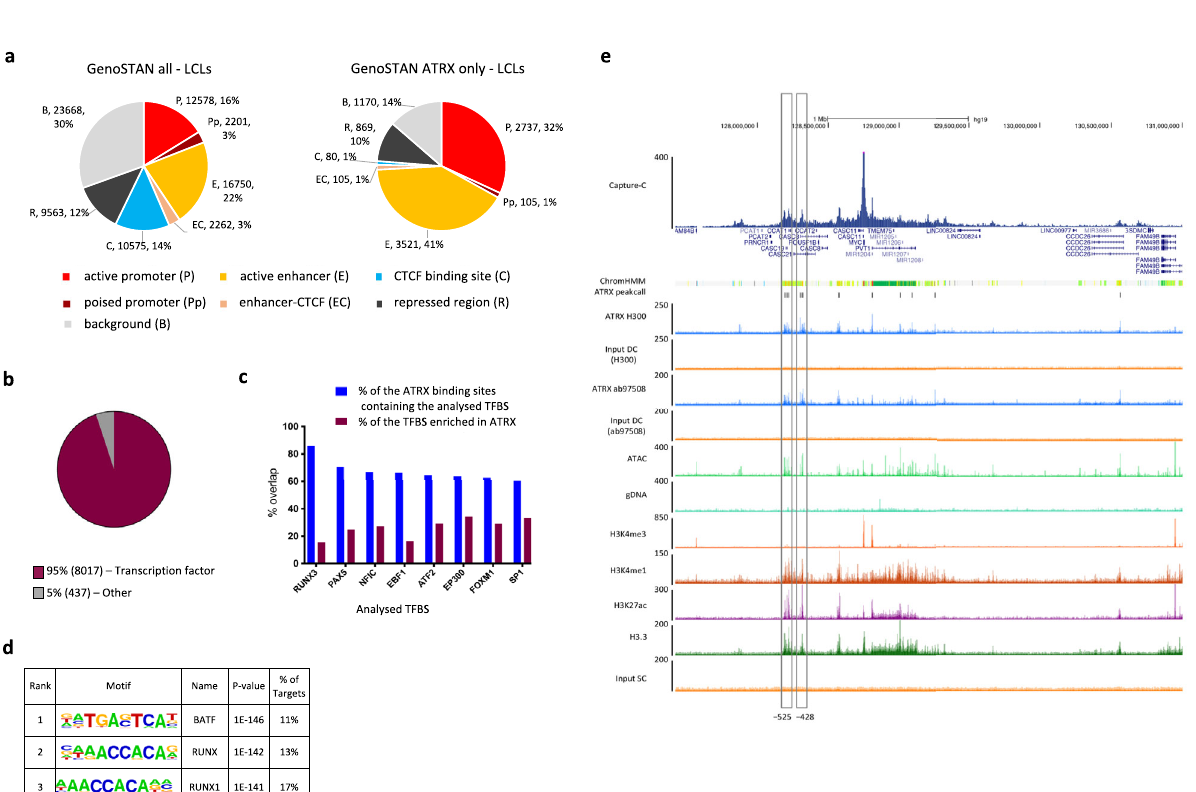
Fig. 1 ATRX binding sites associated with unmethylated CpG clusters and open chromatin regions. a Examples of the variability in pattern and shape of the ATRX binding sites. (i) Example of a broad ATRX binding site enriched in H3K9me3 at a fully methylated CpG island with a background signal in the Bio-CAP experiment (designed to detect unmethylated CpG clusters) 17 , (ii) Example of a sharp ATRX binding site depleted in H3K9me3 at a non- methylated CpG island with an enrichment in the Bio-CAP-seq signal. The signals represent an average of the independent replicates ( n = 3) b Distribution of the ATRX binding sites. c Genome-wide analysis of ATRX enrichment across genes. The ATRX enrichment represents an average of the independent replicates ( n = 3). d Overlap between ATRX peaks annotated CpG islands and non-methylated CpG clusters (Bio-CAP-seq) in LCLs. e Heatmap showing the enrichment in ATRX ( n = 3), Bio-CAP ( n = 3), H3K4me3 ( n = 3), ATAC-seq ( n = 4), Runx3 ( n = 2) and H3K9me3 ( n = 3) signals at all ATRX binding sites subdivided on their genomic location. The read densities represent an average of the independent replicates. f Correlation between Bio-CAP signal ( n = 3 independent replicates) and H3K9me3 signal ( n = 3 independent replicates) at all annotated CpG islands ( n = 27711) in grey and at annotated CpG islands enriched in ATRX ( n = 2580) in blue (data are presented as mean values + / − SEM). g Venn diagram illustrating the overlap between all ATRX binding sites and ATAC-seq peaks.